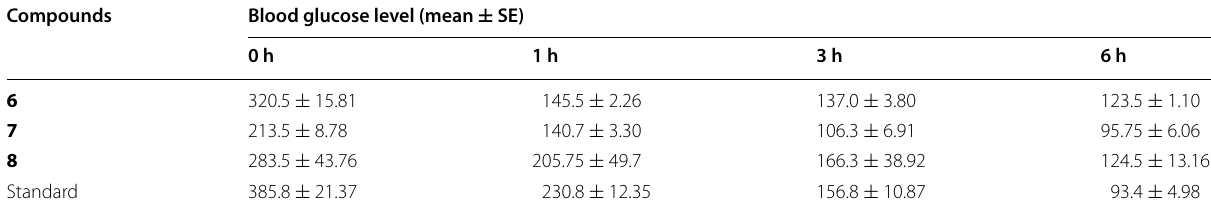
Table 4 Blood glucose level (mg/dl) in synthesized compounds